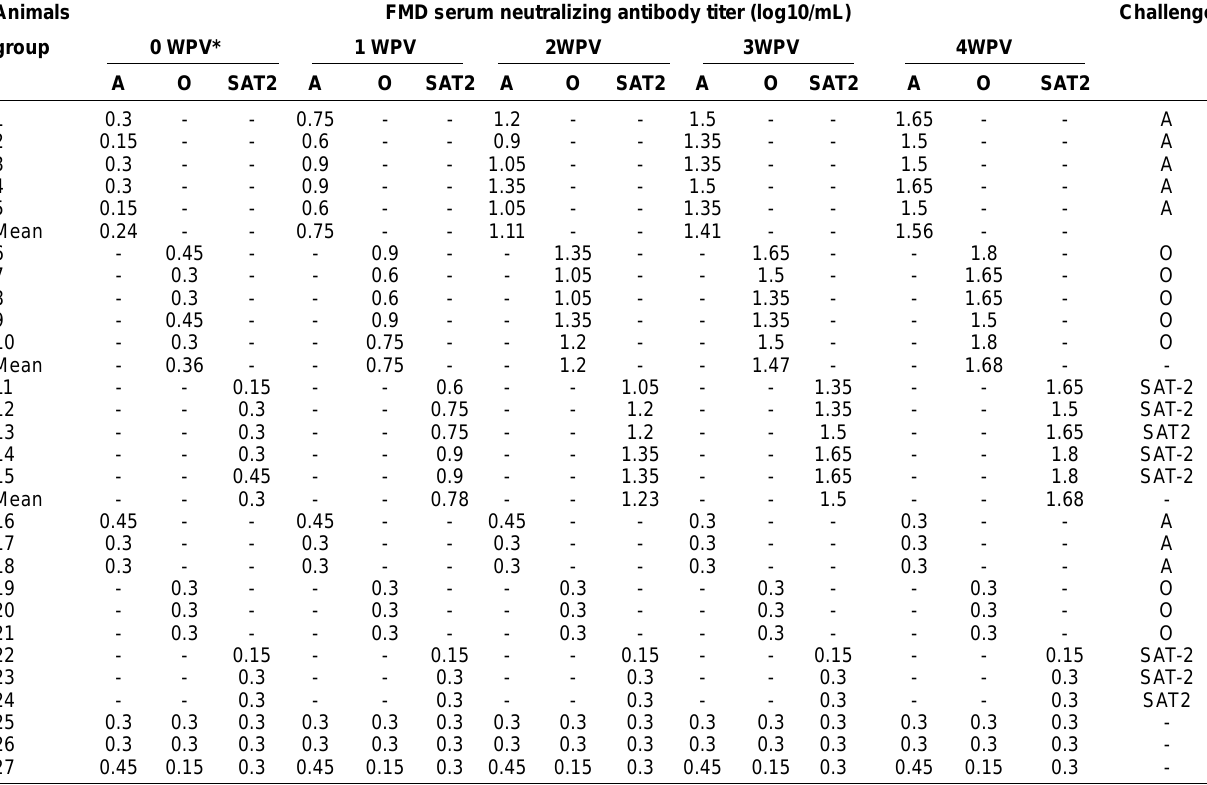
Table-7. FMD serum neutralizing antibody titters in Guinea pigs vaccinated with trivalent FMD inactivated ISA 206 oil vaccine Animals